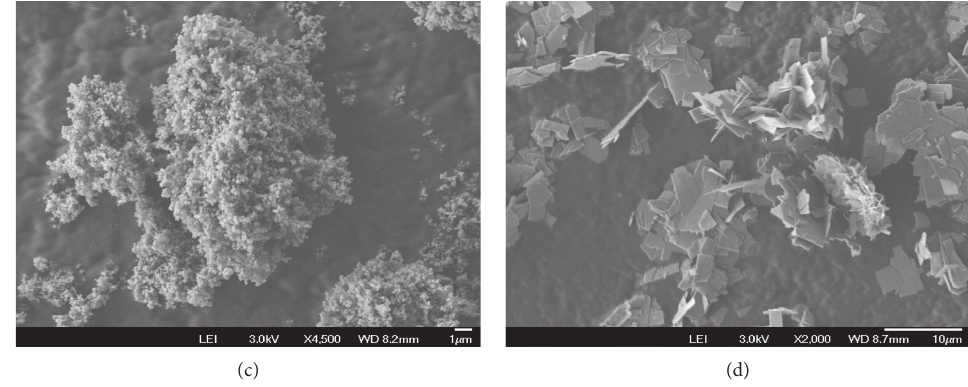
Figure 6: SEM images of the zeolite product samples #18 (a), #20 (b) #27 (c), and #32 (d). Table 4: Synthesis parameters of high-silica CHA zeolites by interzeolite transformation in fluoride media and some product properties. Sample no.